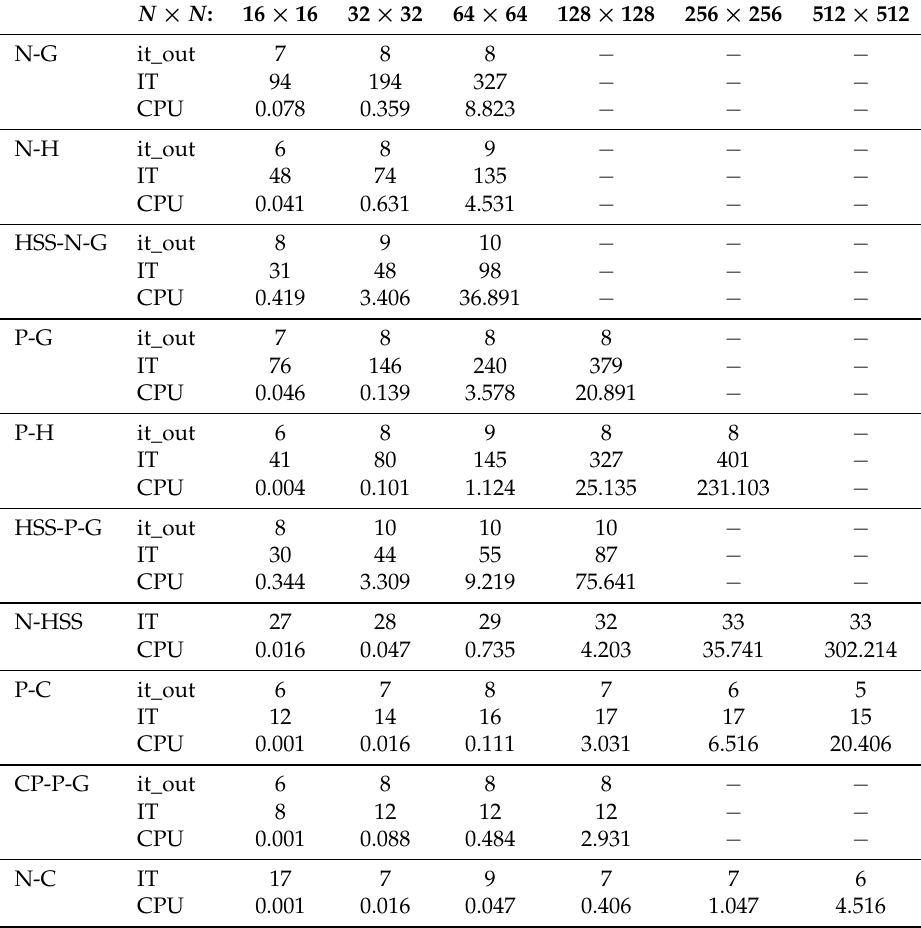
Table 4. Iteration counts and elapsed CPU time for Case 1.1 .